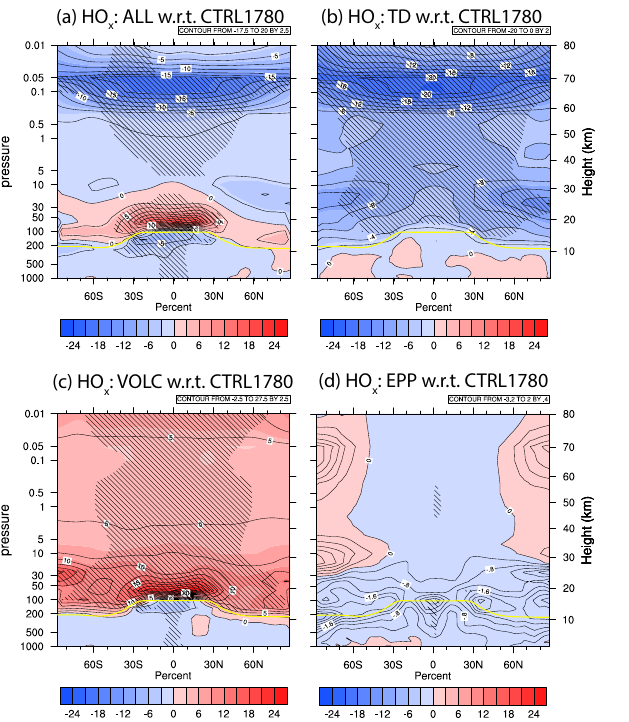
Fig. 5. Relative differences of NO x of the DM-ALL, DM-TD, DM-VOLC and DM-EPP experiments with relation to the DM- CTRL1780 forcing run. Hatched areas are significantly different on a Student’s t test with α = 5%. The yellow line illustrates the height of the WMO